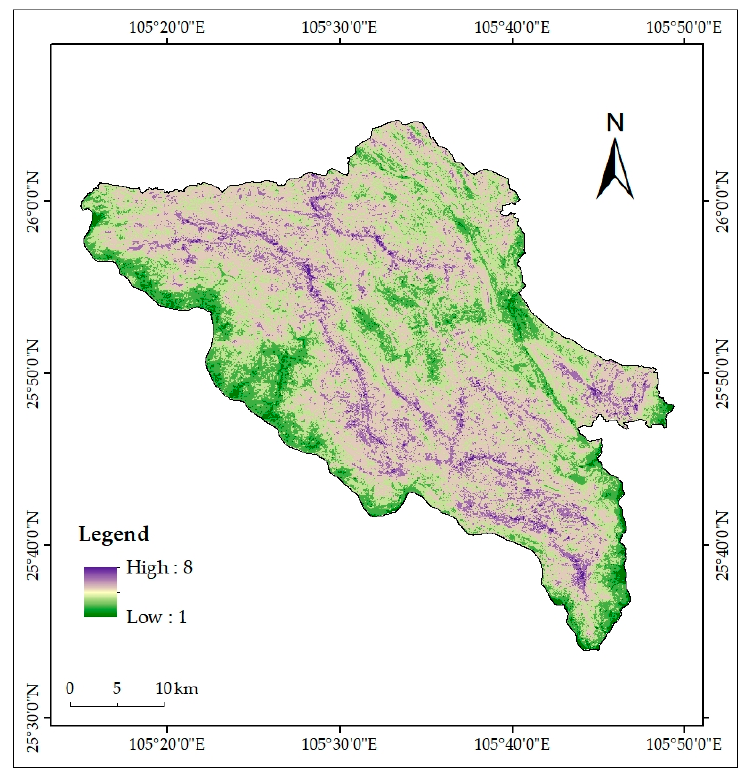
Figure 7. Guanling County comprehensive resistance surface distribution map.